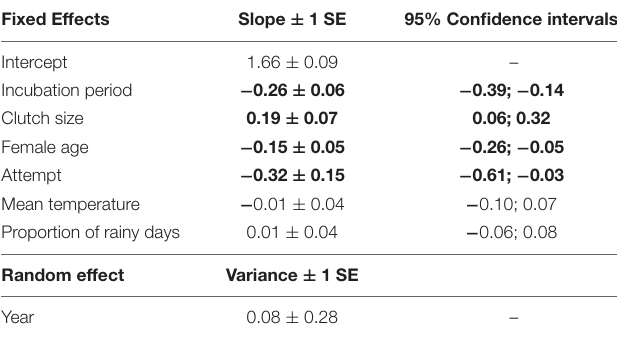
Shown are model-averaged parameter estimates and 95% confidence intervals for each fixed effect, and variance for the random effect from the three best fitting models. Confidence intervals that do not overlap zero are indicated in bold. The model-averaged R 2 LMM ( m ) and R 2 LMM ( c ) were 4.90 and 7.20%,